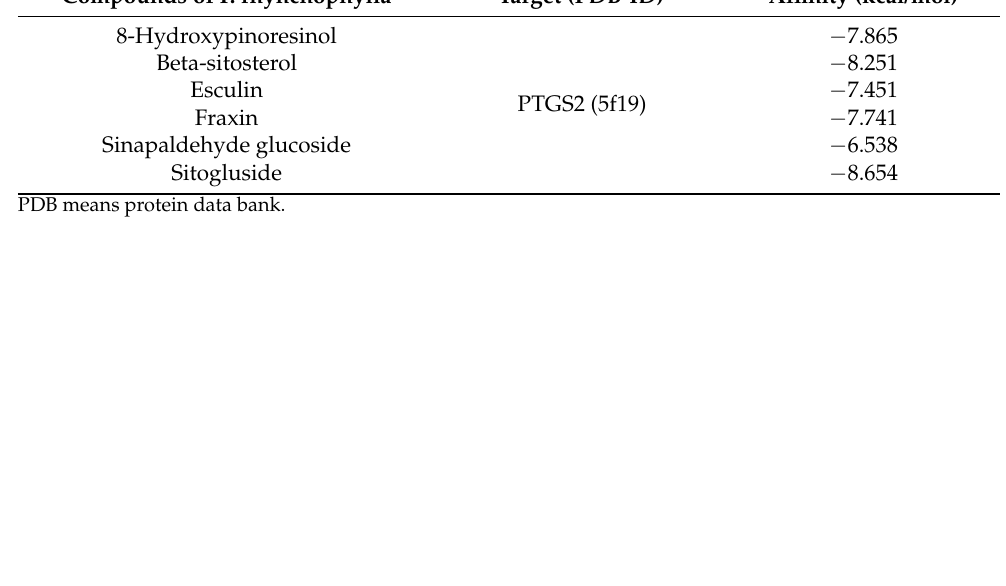
Table 2. Binding affinities for interactions between PTGS2 (COX-2) and the six active compounds. Compounds of F. rhynchophylla